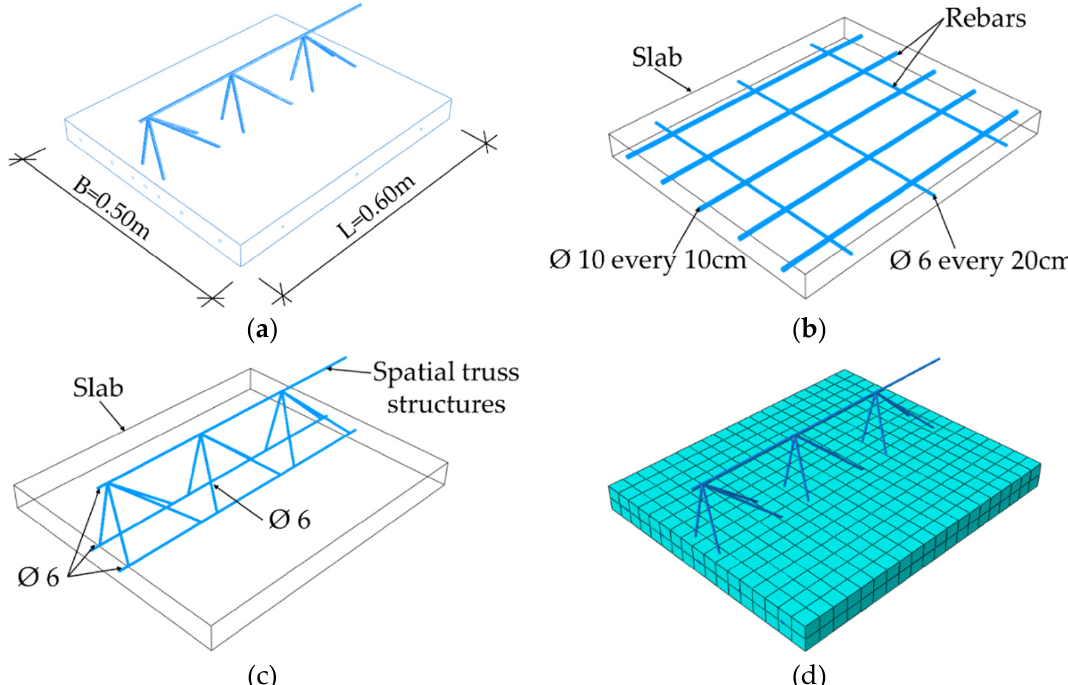
Figure 9. RVE 2—Type-EQ ( a ) geometry; ( b ) rebars; ( c ) spatial truss structure; ( d ) mesh.